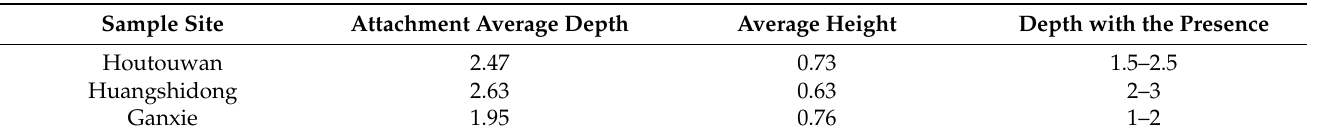
Table 1. The attachment average depth (unit: m), average height of Sargassum horneri (unit: m), and depth with the presence of Sargassum horneri in Houtouwan, Huangshidong, and Ganxie, respectively.